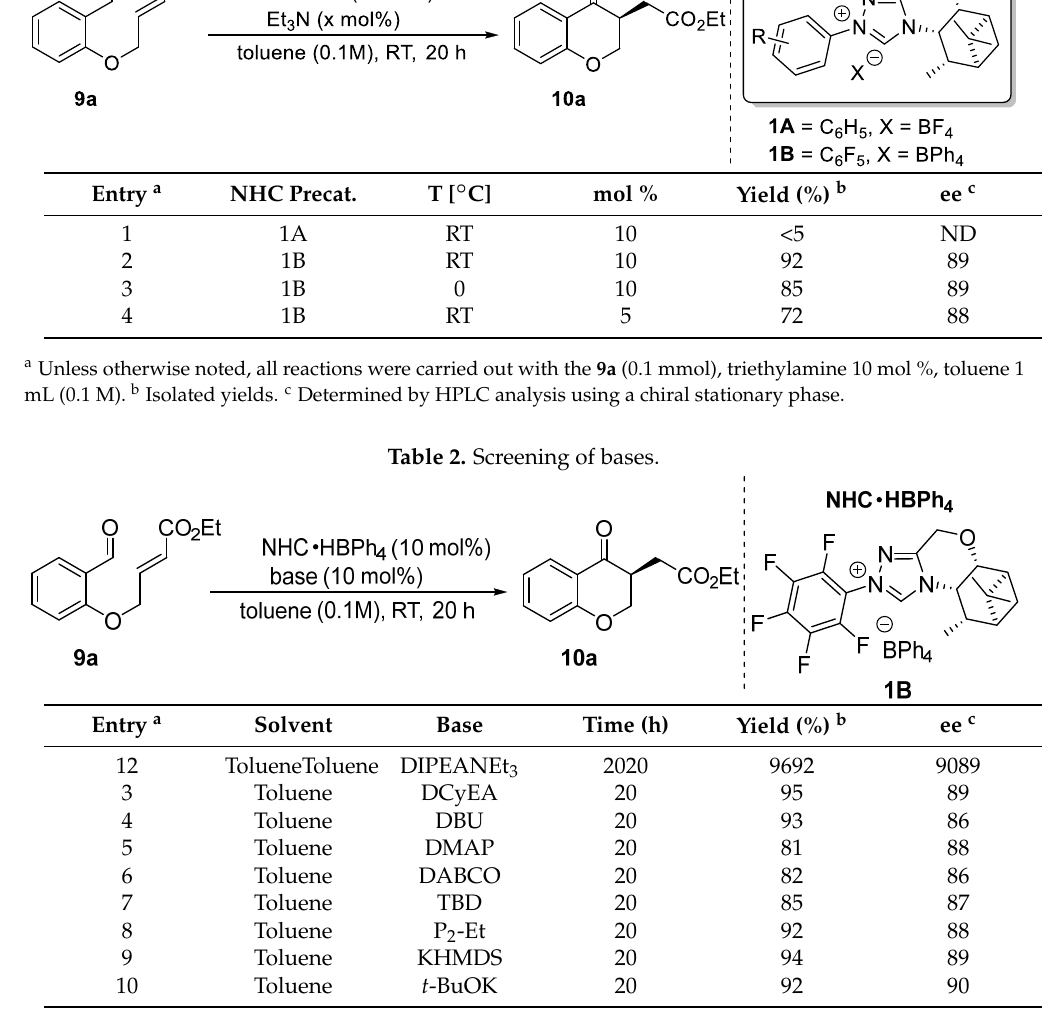
Table 3. Screening of